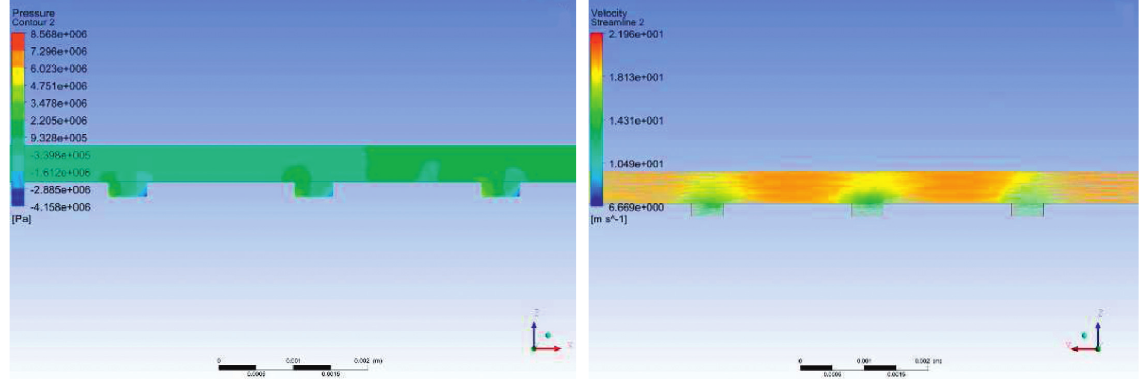
Figure 5: 500 micron diameter and 200 micron depth texture fluid pressure diagram and streamline diagram.